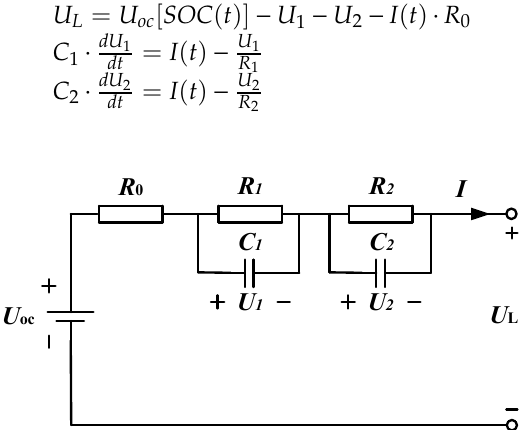
Figure 1. Second-order RC equivalent circuit model.